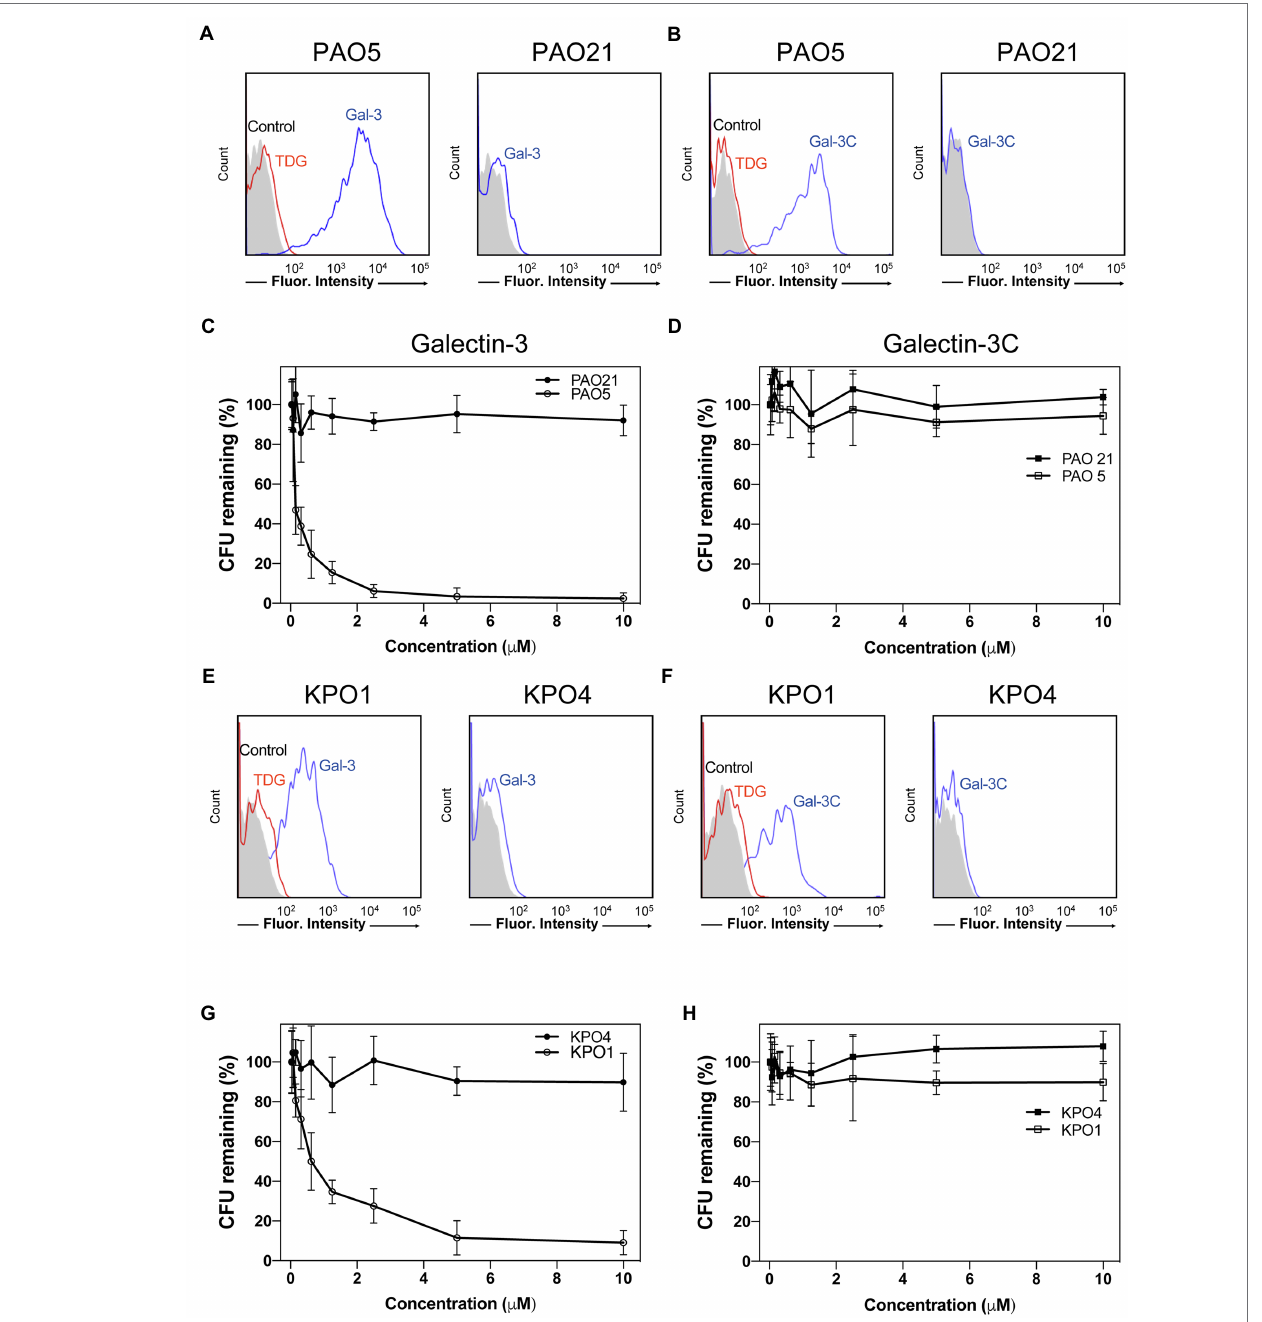
FIGURE 7 | Gal-3 and Gal-3C recognize and kill Providencia alcalifaciens O5 (PA O5) and Klebsiella pneumoniae O1 (KP O1). (A,B) Flow cytometric analysis of Gal-3 (A) and Gal-3C (B) binding to PA O5 and PA O21 with or without inclusion of 20 mM thiodigalactoside (TDG) as indicated. (C,D) Quantification of viable bacteria after incubation with the indicated concentrations Gal-3 (C) and Gal-3C (D) . (E,F) Flow cytometric analysis of Gal-3 (E) and Gal-3C (F) binding to KP O1 and KP O4 with or without inclusion of 20 mM TDG as indicated. (G,H) Quantification of viable bacteria after incubation with the indicated concentrations Gal-3 (G) and Gal-3C (H) . Error bars represent means ±